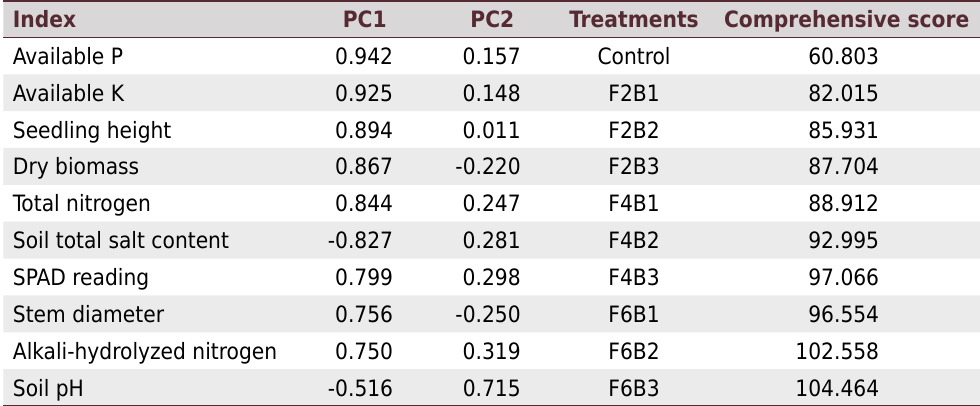
Table 3. Loads of two principal components and the comprehensive score of each